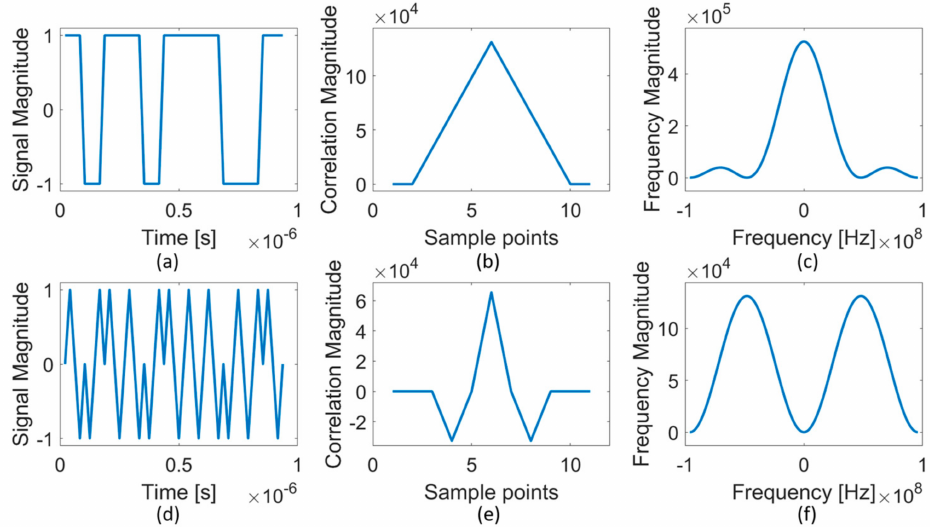
Figure 2. STDR ( a – c ) and SSTDR ( d – f ) signals. The incident signals (a portion of which are shown) are ( a ) STDR PN code and ( d ) SSTDR sine wave modulated PN code at 48 MHz. The resultant correlation is ( b ) STDR a triangle and ( e ) SSTDR triangle multiplied by a sinc . The frequency spectrum of the correlated signals in ( b , e ) are shown in ( c , f